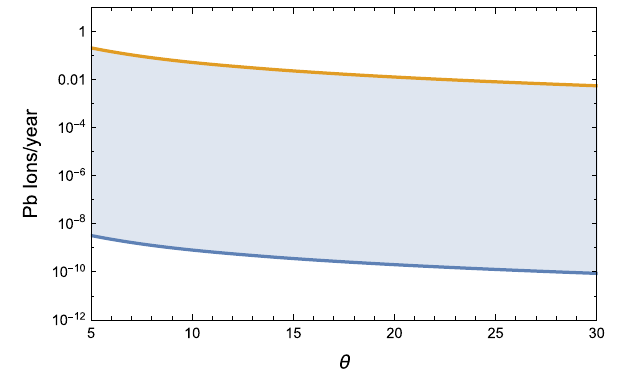
Fig. 6 The figure shows the number of ions scattered by a monopole– anti-monopole pair for a 2 . 76 TeV/nucleon 208 Pb 82 + beam, with β = 0 . 01 and luminosity 10 27 cm − 2 s − 1 . The upper curve is for d ∼ 240 fm (solid) and the lower curve for d = 0 . 03 fm (dashed)